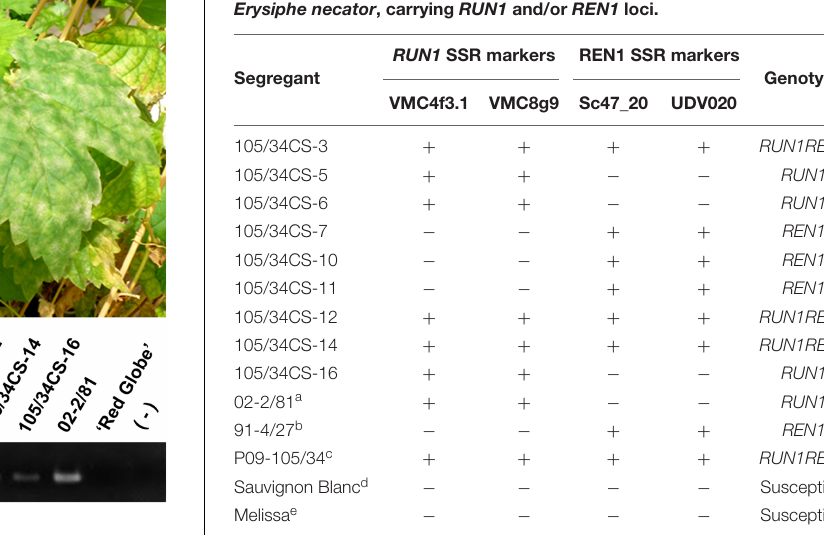
FIGURE 2 | Phenotypic and genotypic analyses of segregating grapevine plants. (A) Phenotyping of plants resistant to infection. Right: powdery mildew development on a susceptible genotype; Left: leaf of resistant segregant carrying RUN1 and/or REN1 loci. (B) Genotyping of resistant plants carrying MrRUN1 , by using specific primers. 105/34CS: grapevine segregating plants resistant to E. necator ; 02-2/81: MrRUN1 positive control; ‘Red Globe’: MrRUN1 negative control; (-): DNA negative control; arrow shows a 190 bp DNA fragment expected to amplify in MrRUN1 positive plants.